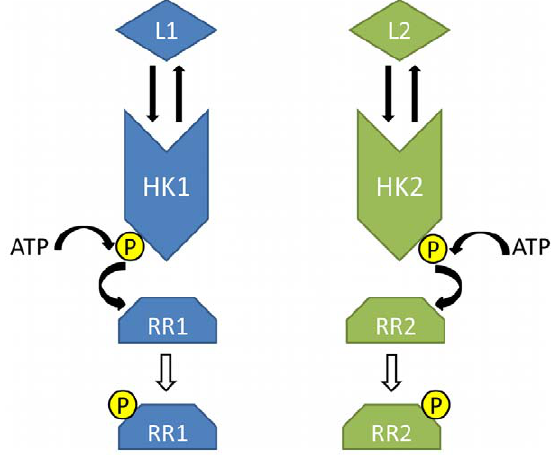
Figure 2. Bacterial two component system schematic model. Note that unlike the mammalian system a single phosphate group is transferred from the cell surface histidine kinase receptor to the response regulator.